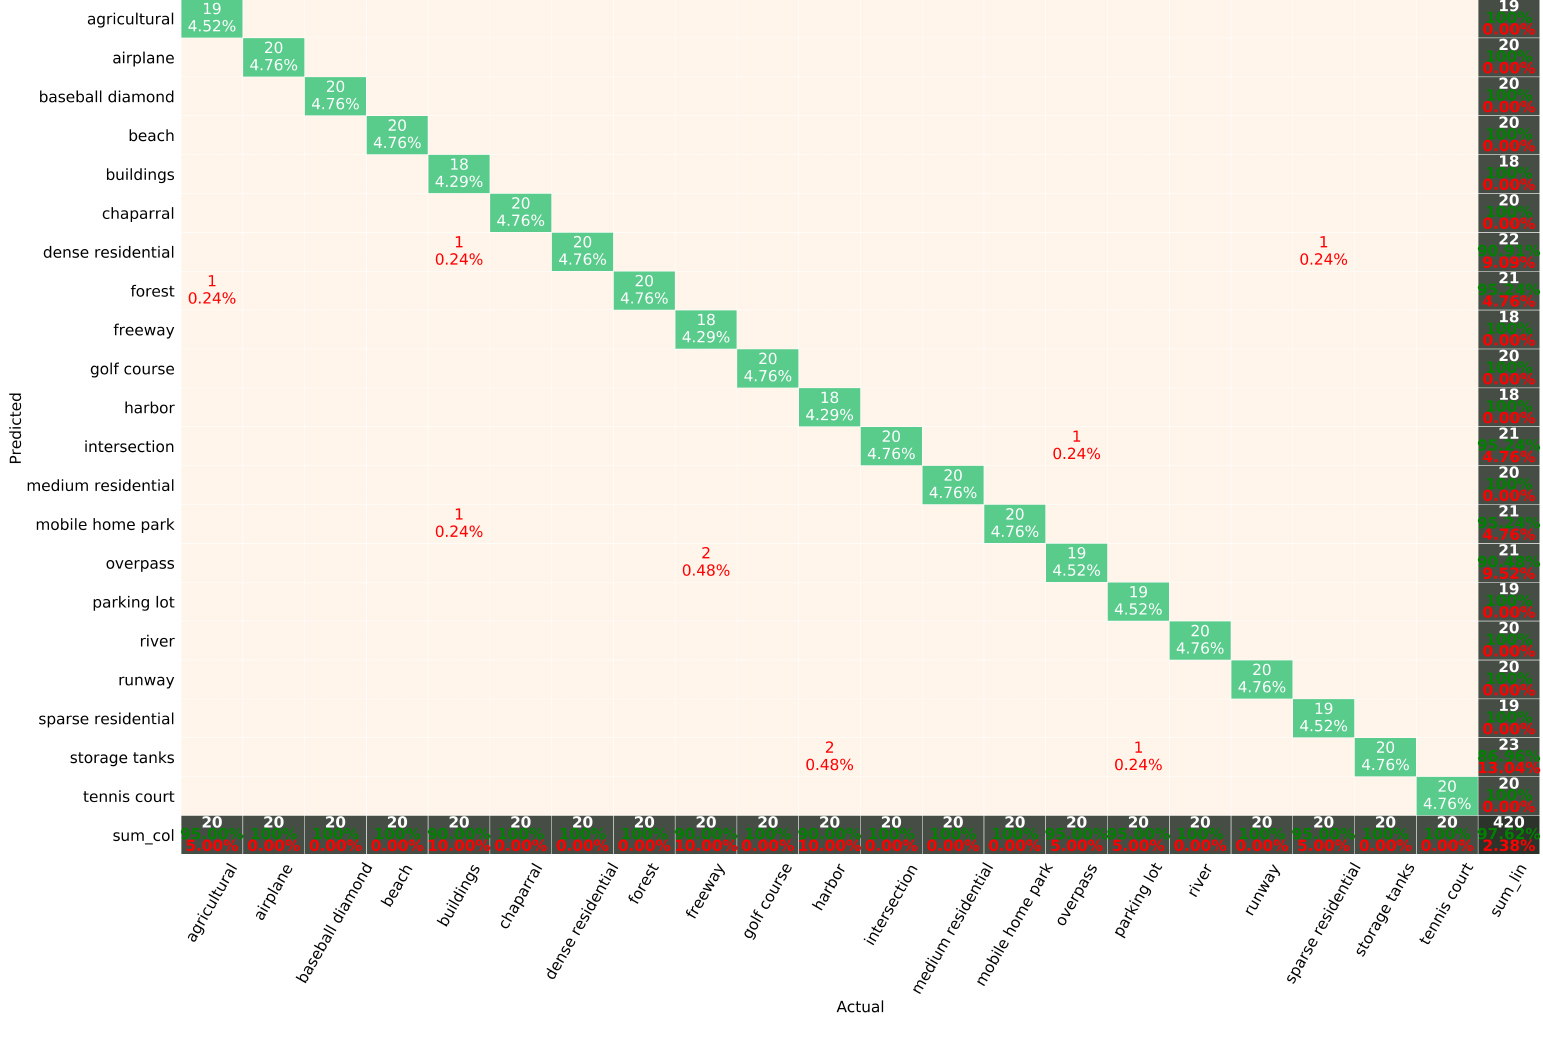
Figure 12. Confusion matrix of ResNet-50 on UC_MerceLandUse test